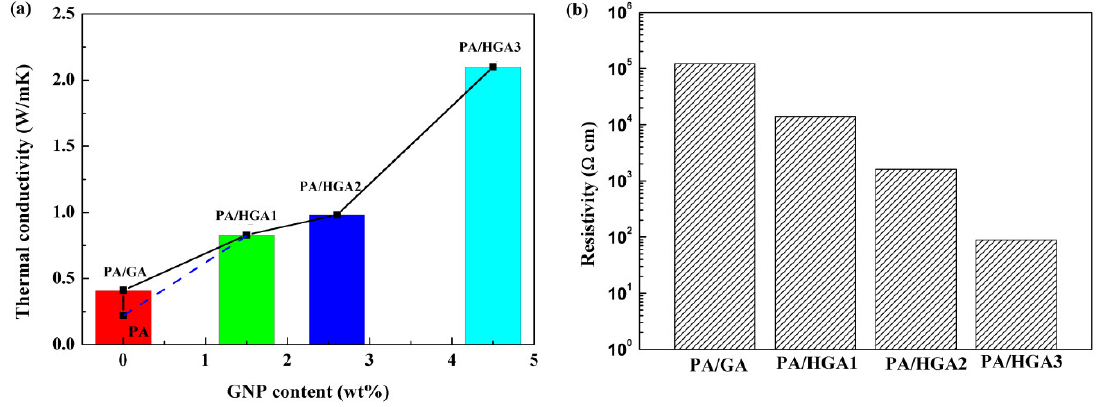
Figure 7. T hermal conductivity ( a ) and electrical resistivity ( b ) of PA and PA/HGA. Figure 7. Thermal conductivity ( a ) and electrical resistivity ( b ) of PA and